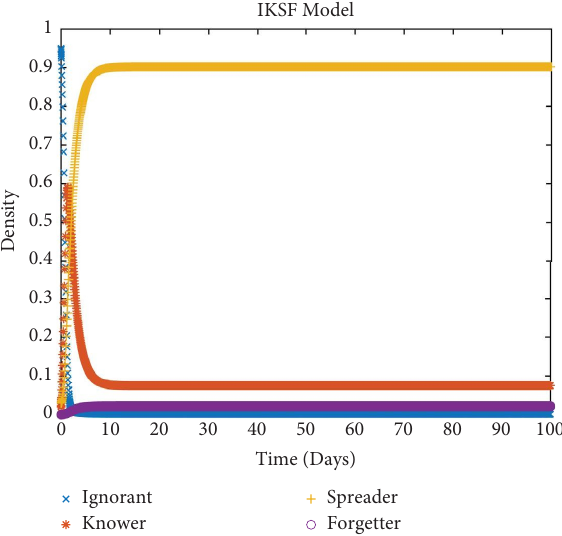
Figure 6: Diagram of density change of four types of population when R